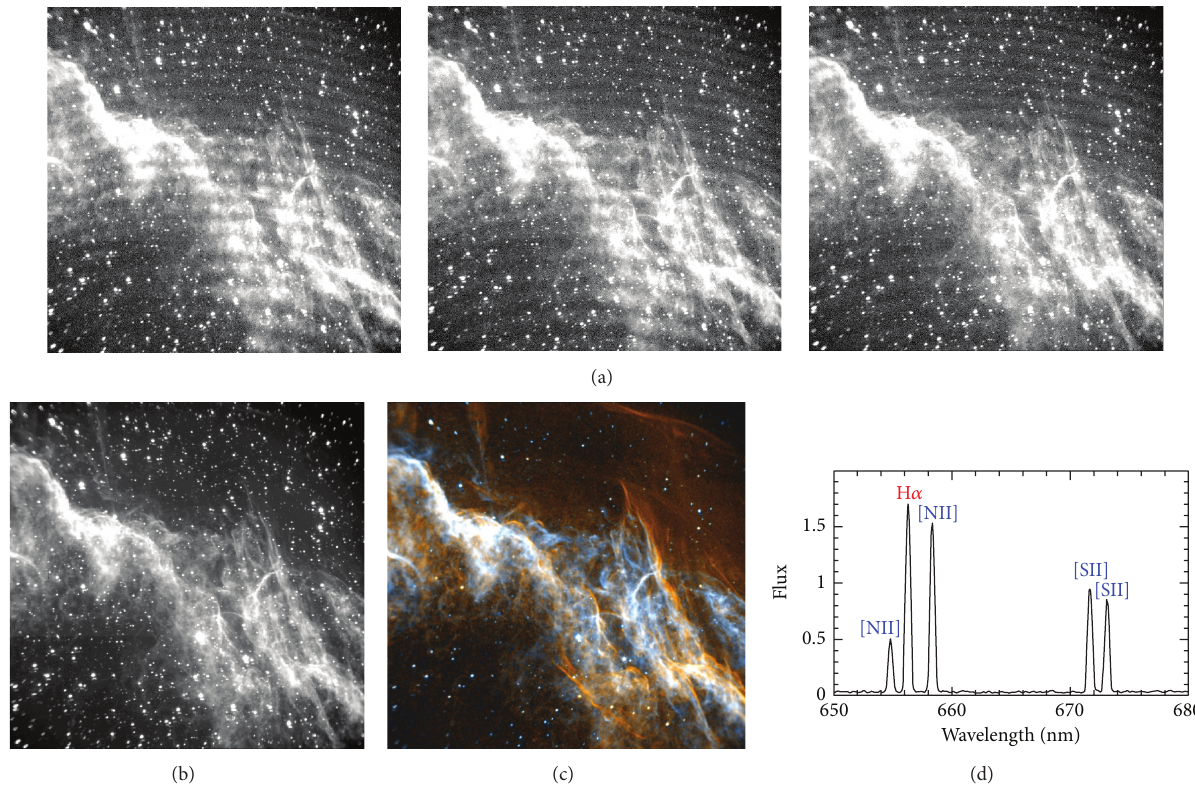
Figure 2: (a) Series of 12 󸀠 × 12 󸀠 images from a raw data cube (only one camera is shown). The target is a section of NGC 6992 (Cygnus Loop), obtained through a 650–680 nm filter with SpIOMM (Section 2.3). Notice the fringes, moving from one frame to the next, caused by a combination of night sky (OH) and nebular (H 𝛼 , [NII], [SII]) emission lines. (b) Images from the raw data cube can be co-added to provide a deep, panchromatic image (within the limits of the filter). (c) This image is obtained after Fourier transforming the original data cube and extracting the H 𝛼 (red) and [NII] 6584 (blue) images. (d) Spectrum from a group of 2 × 2 pixels in the same cube. Doppler maps of the field can also be extracted for each line from the ∼ 400000 spectra in this